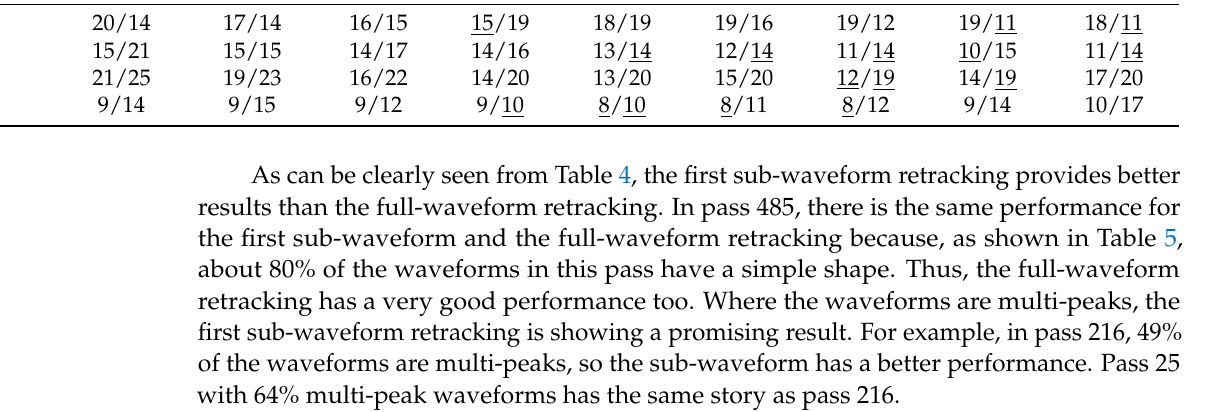
Table 7. RMSEs (cm) of the water level from retracking the first sub-waveforms in Table 4. RMSEs (cm) of the water level from retracking the first sub-waveform and the full-wave-